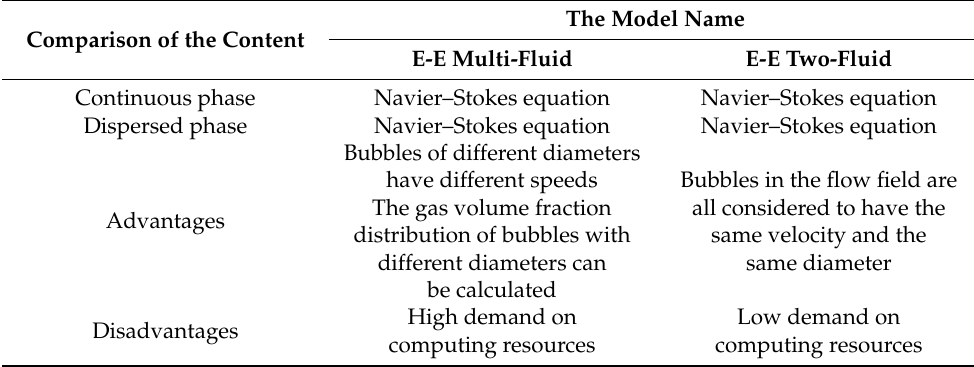
Table 2. Comparison of two numerical methods.